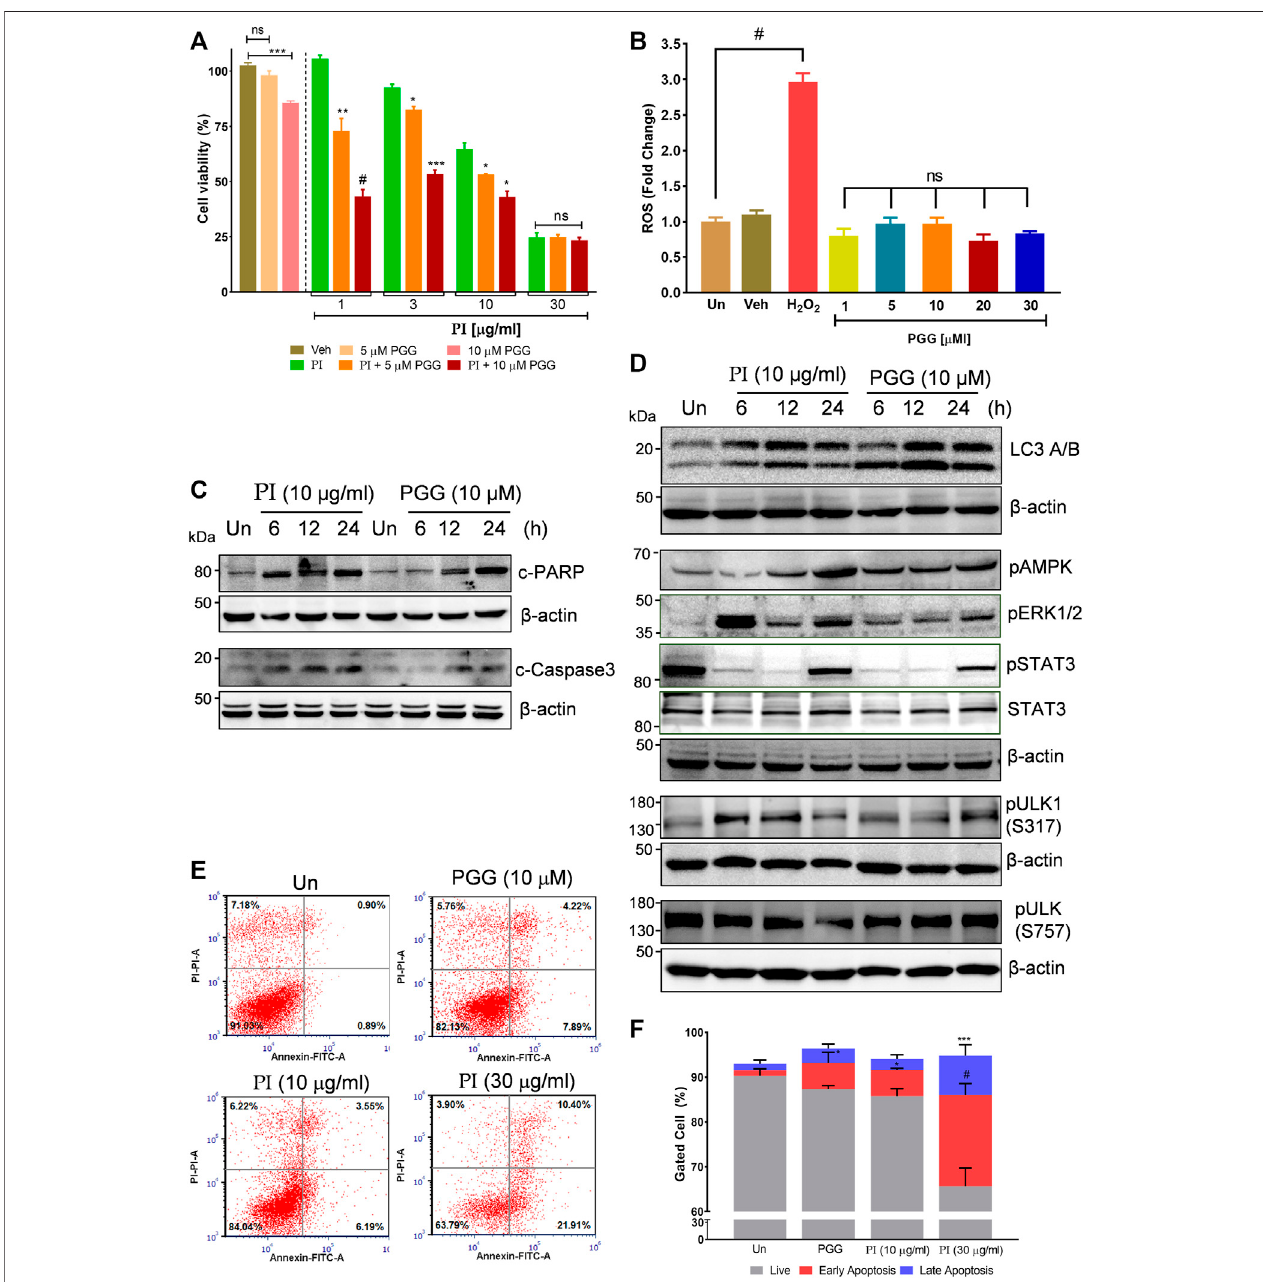
FIGURE 6 | Penta-O-galloyl- β -D-glucose (PGG) activates AMPK and ERK and inhibits STAT3 signaling in lung cancer cells. (A) Percent cell viability calculated in A549 cells treated for 24 h with 5 and 10 μ M of PGG alone or in presence of PI at indicated concentrations. Signi fi cance in PI + 5 μ M PGG and PI + 10 μ M PGG was calculated with respect to PI alone ( n = 3). Error bars represent mean ± SEM; signi fi cance of data represented as * p < 0.05, ** p < 0.005, *** p < 0.0005, and # p < 0.0001andnotsigni fi cant(ns)if p > 0.05. (B) A549cellspostPGGtreatmentfor24 hwerestainedwithDCFDAfor45 min.Fluorescentunitsweremeasuredusing amulti-platereaderandwereexpressedinrelativefoldchangewithrespecttountreated.ThefoldchangedifferenceinPItreatmentswasnon-signi fi cant(ns)withrespect to untreated. H 2 O 2 served as a positive control for DCFDA fl uorescence. Error bars represent mean ± SEM; signi fi cance of data represented as # p < 0.0001 and not signi fi cant (ns) if p > 0.05. (C) Whole cell lysates of A549 cells, at indicated treatments of PI (10 μ g/ml) and PGG (10 μ M), were subjected to Western blotting using antibodiesagainstcleavedPARP1andcleavedcaspase3. β -Actinservedastheloadingcontrol. (D) WholecelllysatesofA549cells,treatedwithPI(10 μ g/ml)andPGG (10 μ M), were subjected to Western blotting using antibodies against LC3A/B, pAMPK, pERK1/2, pSTAT3(Y705), STAT3, pULK1(S317), and pULK1(S757). β -Actin served as a loading control. (E) Representative dot plots obtained from fl ow cytometric analysis of A549 cells with indicated treatments of PI and PGG (10 μ M) for 24 h. Cells were stained with PI (propidium iodide) and Annexin V FITC to evaluate the percentage of cells undergoing apoptosis, indicated in each quadrant. (F) The panel shows graphically the percentage of live and apoptotic cells representing mean ± SEM from three experimental replicates.